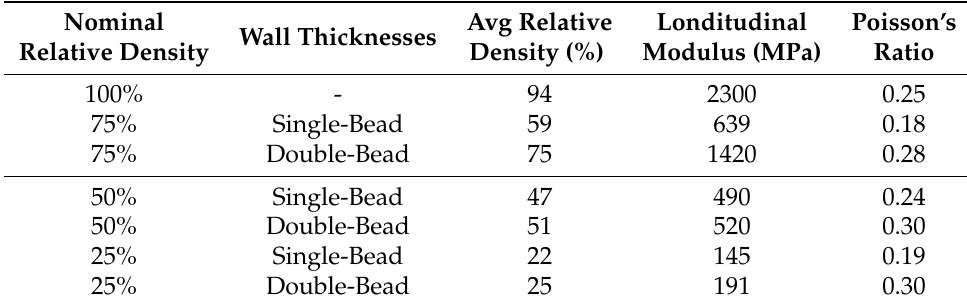
Table 1. Summary of experimental